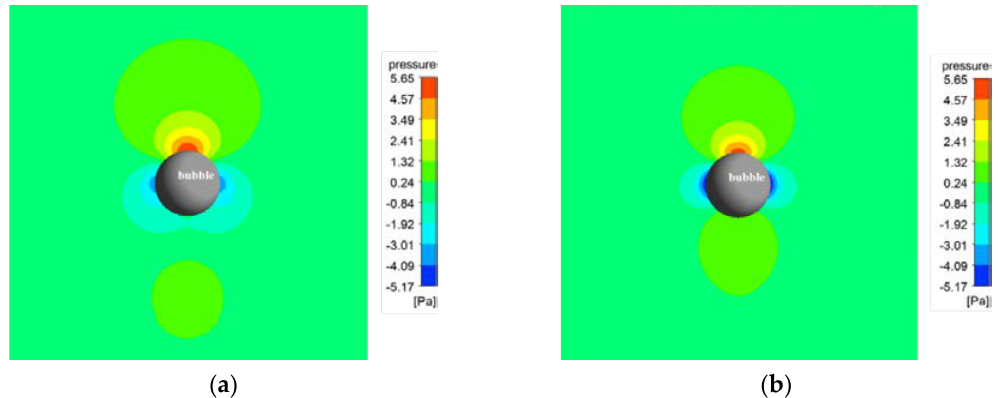
Figure 6. Water pressure contour at bubble diameter = 0.9 mm. ( a ) immobile surface bubble; ( b ) mobile